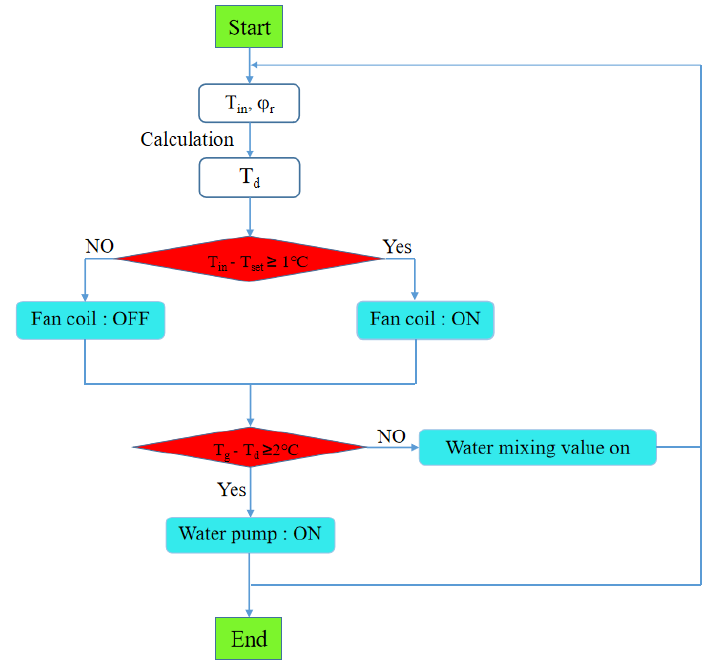
Figure 6. Control logic of the cooling system.